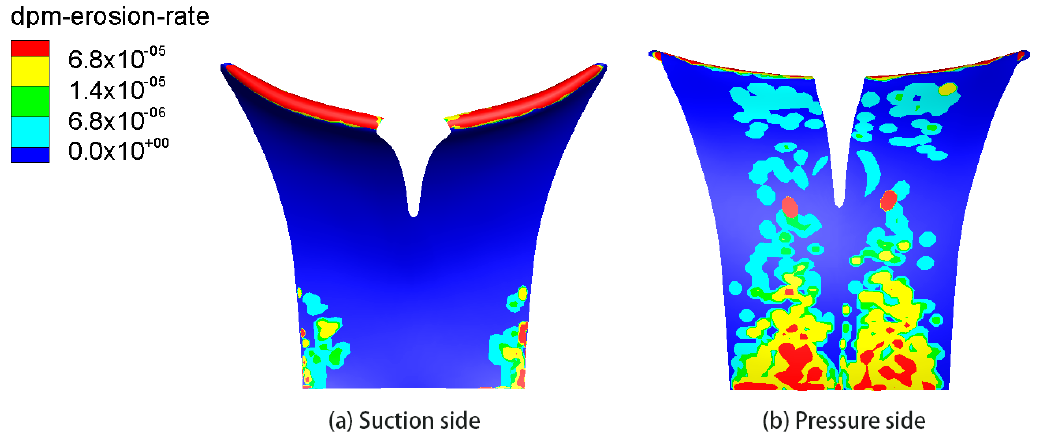
Figure 10. Silt erosion on blade surface (units: μ m/s, particle size: 0.2375 mm).